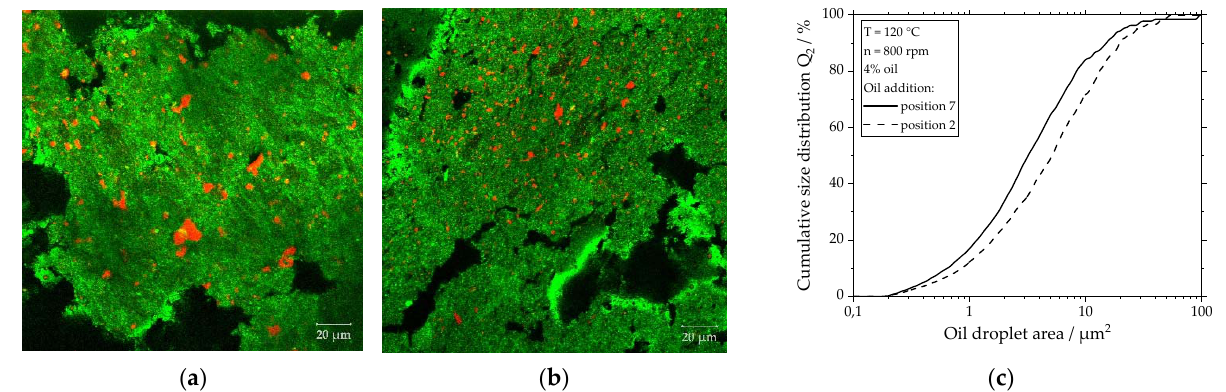
Figure 10. Influence of the oil addition point on the morphology and droplet size of the dispersed oil phase (red) in the protein matrix (green). CLSM images of samples with 4% oil that was added at ( a ) position 2 and ( b ) position 7. ( c ) Oil droplet size distribution for the samples depicted in ( a ) and ( b ). The barrel temperature was 120 °C and screw speed was 800 rpm.